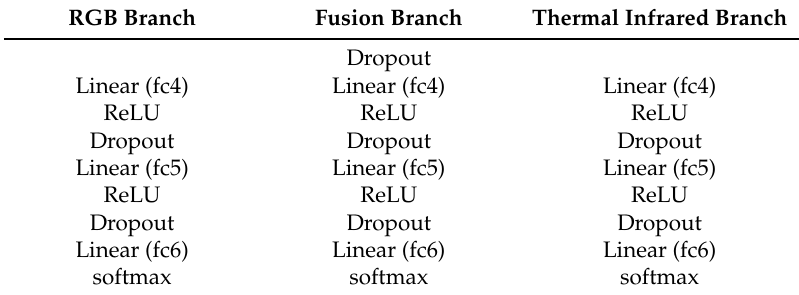
Table 2. The configuration of classification network and architecture